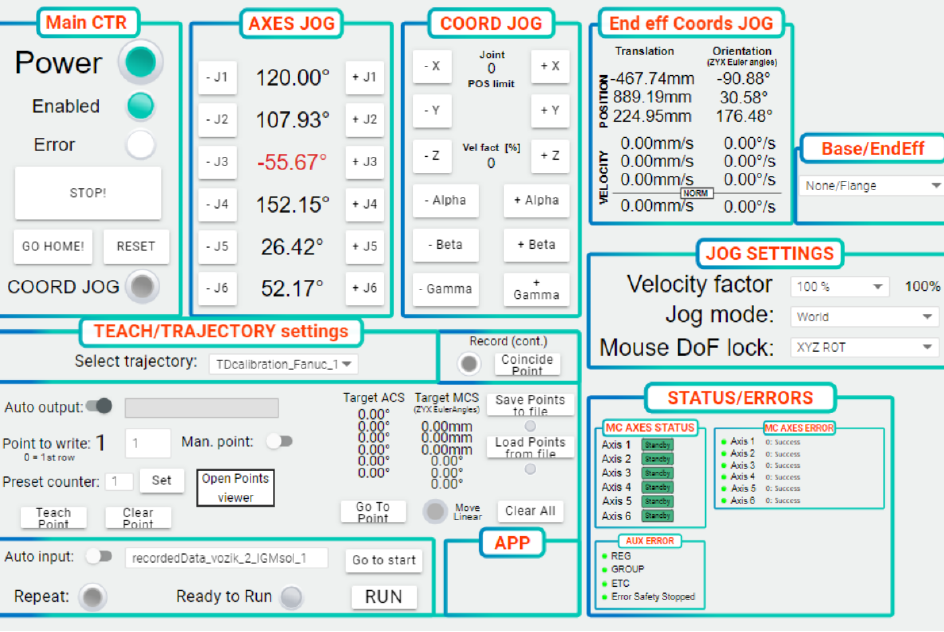
Figure 9. Human machine interface—low-level part for robot motion